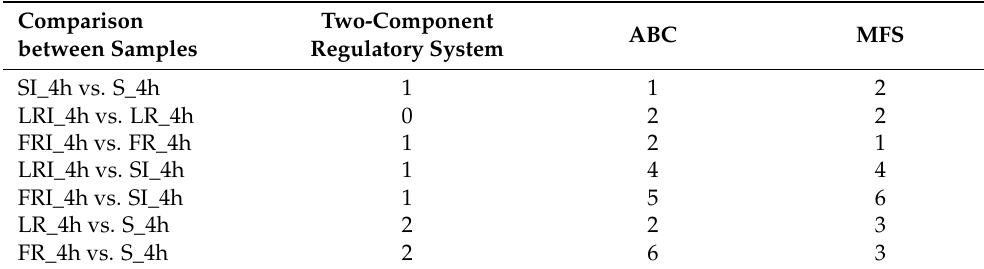
Figure 4. Venn diagram of the DEGs shared in the DEG groups SI_4h vs. S_4h—LRI_4h vs. LR_4h—FRI_4h vs. FR_4h ( I ) and the DEG groups LR_4h vs. S_4h—FR_4h vs. S_4h—LRI_4h vs. SI_4h—FRI_4h vs. SI_4h ( II ). The overlapping region indicates shared DEGs of the two compared groups. Table 3. Analysis of the target protein genes associated with fludioxonil resistance among the identified DEGs.